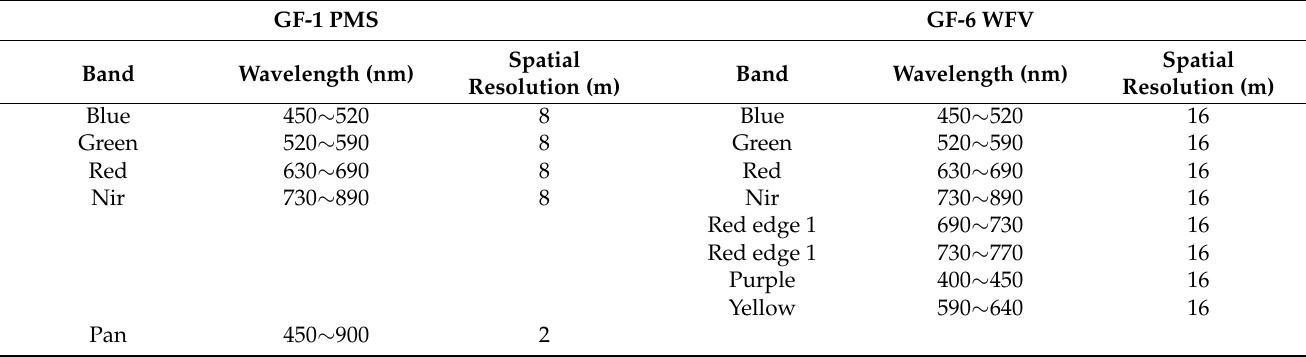
Table 1. Band specification of the GF-1 PMS and GF-6 WFV